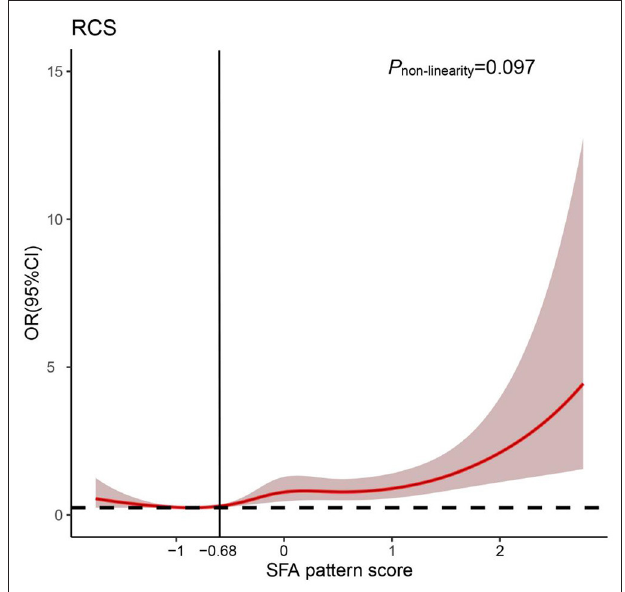
FIGURE 2 | Odds ratio ( OR ) based on saturated fatty acid “(SFA) pattern” score and restricted cubic spline ( P non − linearity = 0.097). OR was adjusted for the same variates as in model